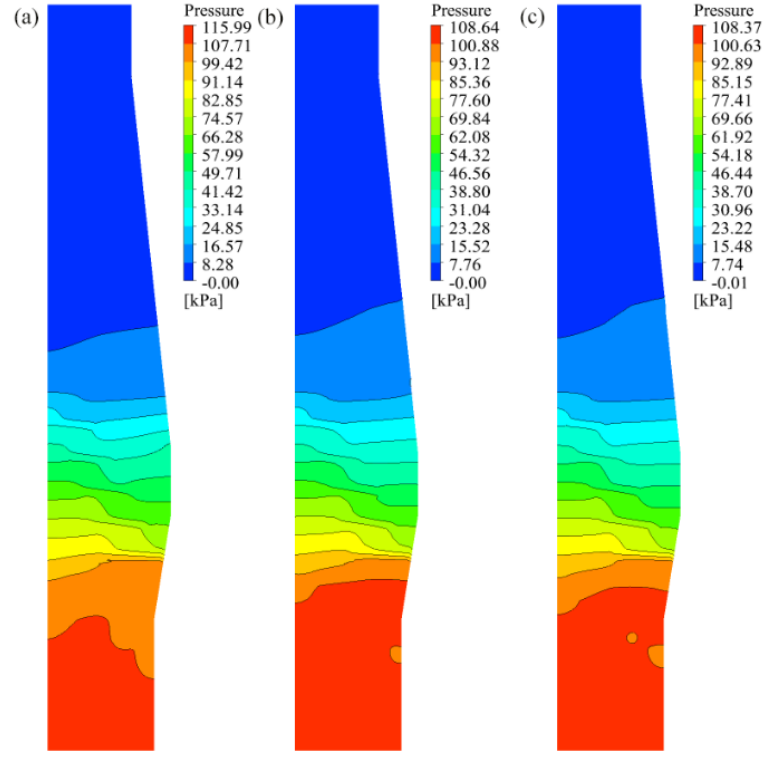
9 of 14 Figure 6. Path line of cohesive zone in a traditional BF (R = 50%, 𝛾𝛾 = 60°, n = 6): ( a ) without central coke; ( b ) with central coke. For central coke charging, a gas channel from the raceway to the furnace top is formed directly. Therefore, the gas flow velocity in the central region at the outlet is large, while the gas flow velocity through the CL of the cohesive zone is relatively small. By comparing the velocity contour and the path line of the two charging systems, this model can explain the formation mechanism of two in-furnace gas streams, the primary distri- bution function performed by the raceway, and the secondary distribution function per- formed by the cohesive zone. 4.2. Influence of Different Stack Tuyere Heights As a supplement for insufficient heat in the stack, the TGR-OBF designs a set of tuy- eres for injecting heated recycling gas into the stack. In this section, three kinds of stack